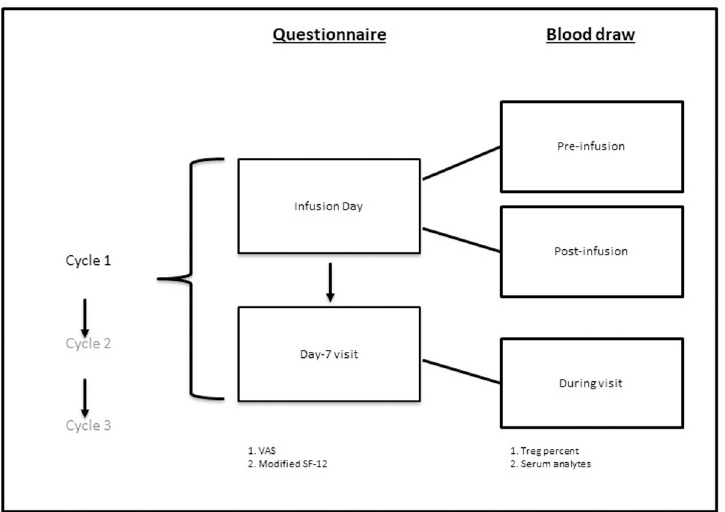
Fig 1. Outline of study visits. Subjects participated in three identical cycles. Each cycle consisted of an infusion-day visit and a day-7 visit (2 visits per cycle). Questionnaires were completed once per study visit day for a total of 6 time points. Blood was drawn for Treg levels and blood analytes 3 times per cycle, twice on the infusion day (before infusion and 1 hour after completion) and once at the day-7 visit.